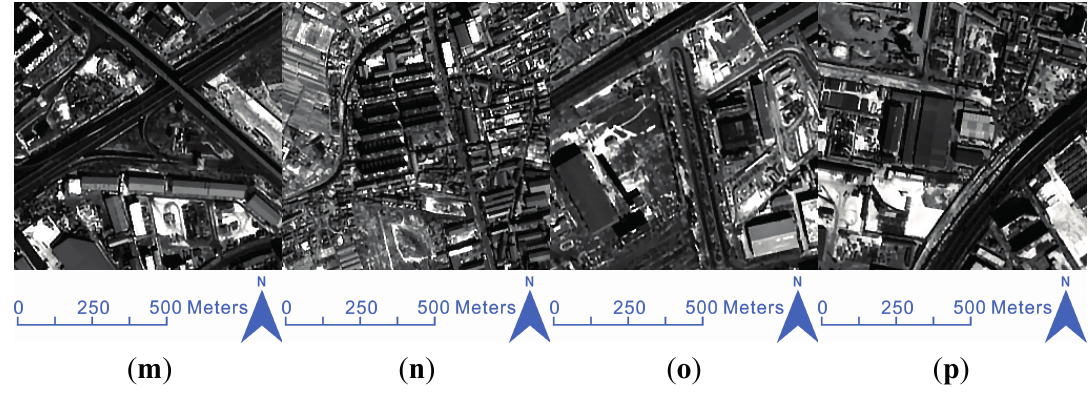
Figure 17. Profiles of the final PSFs of AM-Kedge for experiments 1–8: ( a – h ) are the corresponding final PSFs of Figure